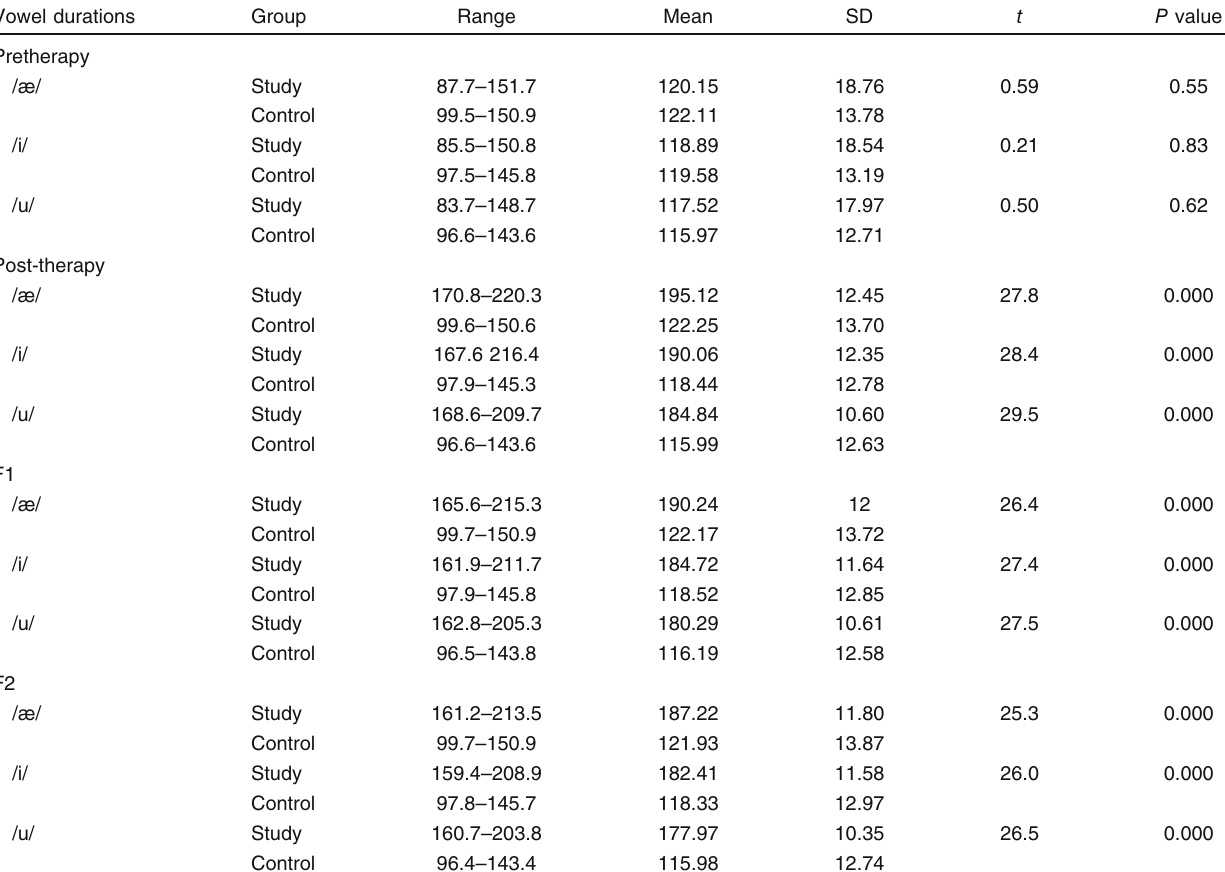
Table 8 Comparison between the study group and the control group as regards vowel duration